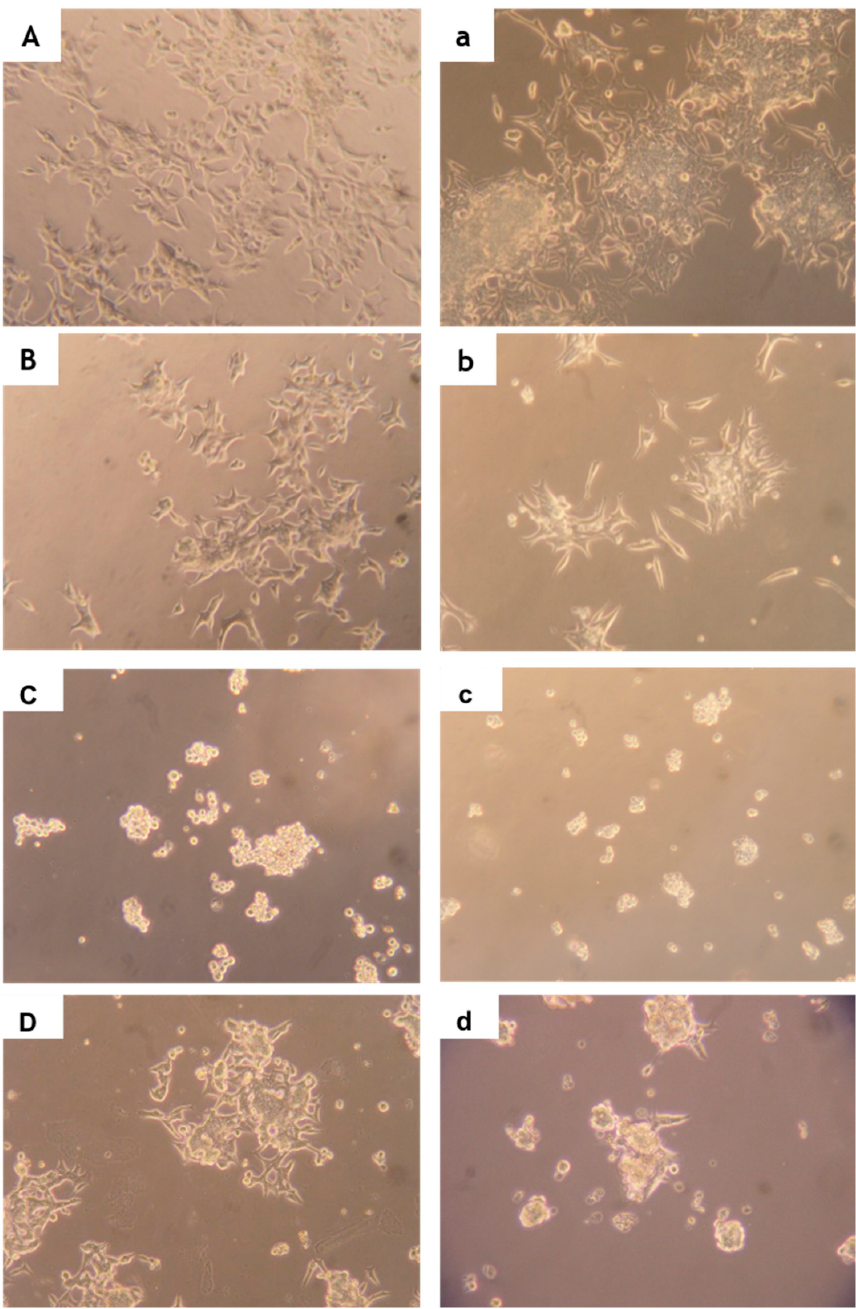
Figure 6. Photograph shots after incubation of LNCaP cells with the compounds (24 and 72 h, zoom: 100 × ). ( A ) Control after 24 h, ( a ) control after 72 h; ( B ) cells after 24 h of incubation with finasteride, ( b ) cells after 72 h of incubation with finasteride; ( C ) cells after 24 h of incubation with 3g , ( c ) cells after 72 h of incubation with 3g ; and ( D ) cells after 24 h of incubation with 5-fluorouracil (5-FU), ( d ) cells after 72 h of incubation with 5-FU.